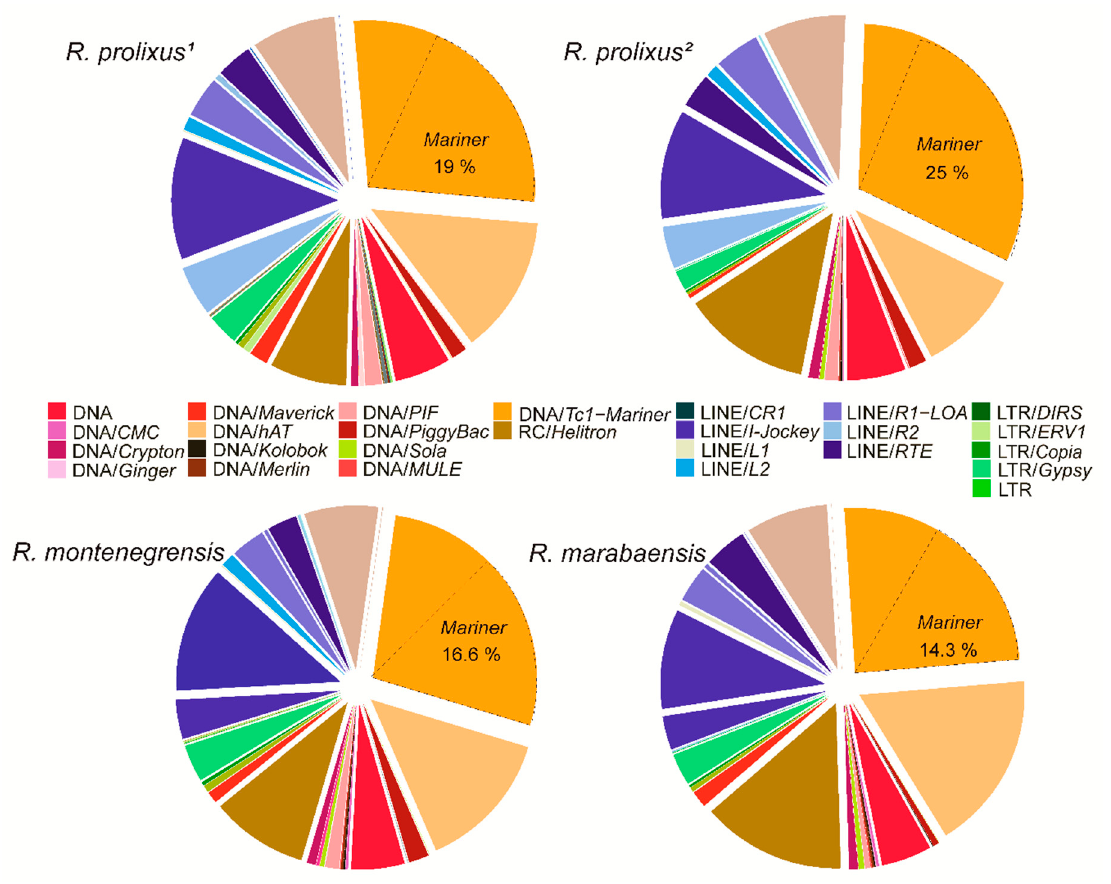
Figure 2. Relative repeatome proportions of main superfamilies from dnaPipeTE annotation (BLASTN with 0.25_ genome coverage) for R. prolixus ( 1 and 2 ) and R. montenegrensis and R. marabaensis ).